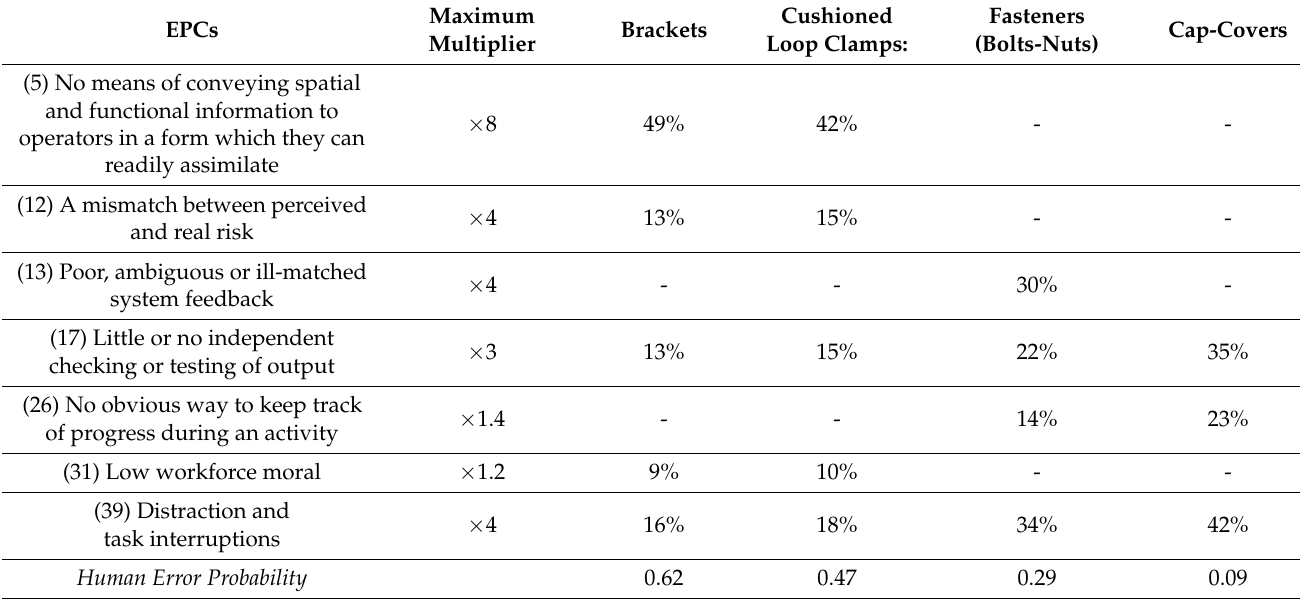
Table 5. Consolidated results of HEP calculations and error producing conditions with their respective % contribution 1 .